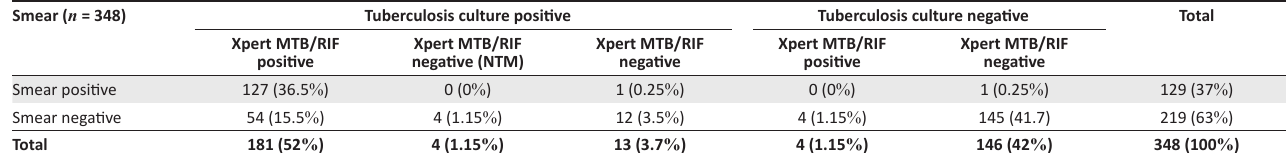
TABLE 1: Comparison of Xpert MTB/RIF and culture diagnostic test results in relation to smear microscopy for outpatients at a single hospital in Lilongwe, Malawi (2011–2012). Smear ( n =